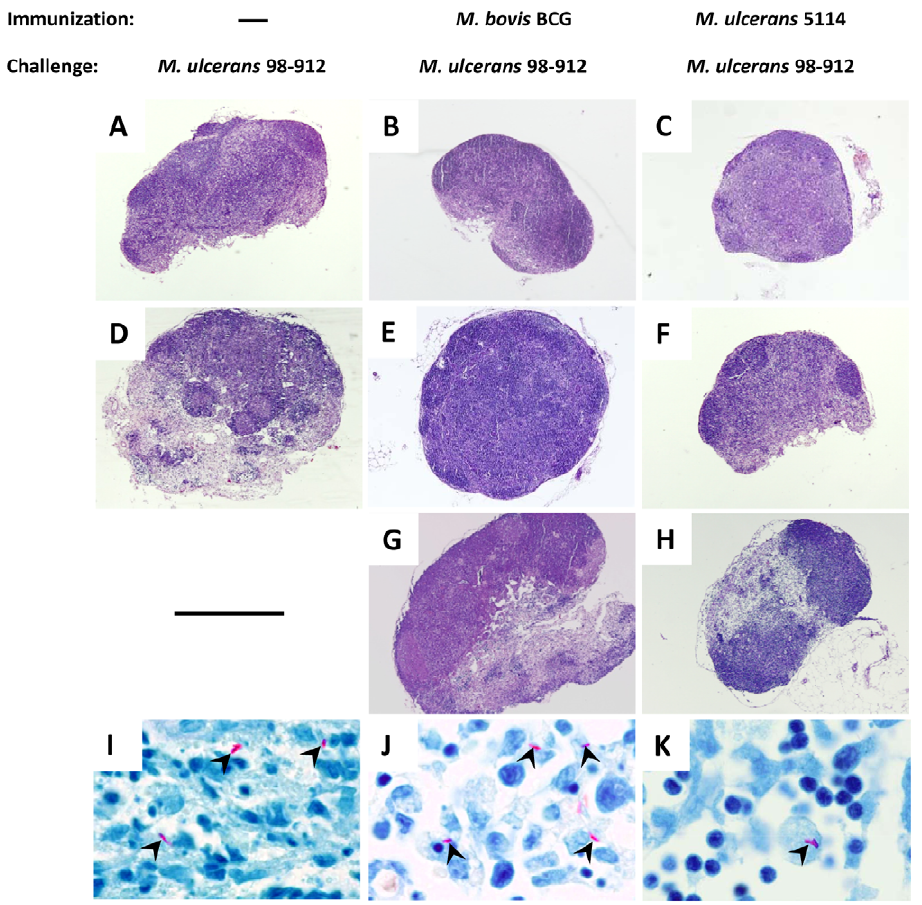
Figure 8. Immunization with BCG or mycolactone-negative M.ulcerans 5114 delays the destruction of the DLN during infection with virulent M.ulcerans . Mice were either non-immunized (A, D, and I) or immunized with BCG (B, E, G, and J) or with mycolactone-negative M. ulcerans 5114 (C, F, H, K) two months before challenge. All mice were infected in the footpad with 2 log 10 CFU of M. ulcerans 98–912. The DLN were recovered at day 60 (A–C), day 70 (D–F and I), and days 100–200 (G–H and J–K) and processed for histology. Tissue sections were stained with HE (A–H) or ZN (I– K). (A, D, and I) In non-immunized mice infection resulted in extensive areas of necrosis and bacterial colonization by day 70 post-infection. (B, C, E, F, G, H, J, and K) Immunized mice showed no alterations in the structure of the DLN during these first 70 days. As the infectious process progressed in immunized mice, bacilli could be found throughout the tissue (arrowheads) along with signs of tissue destruction. Images are representative of 4 lymph nodes per group analyzed. Original magnification (A–H): 4 6 . Original magnification (I–K): 100 6